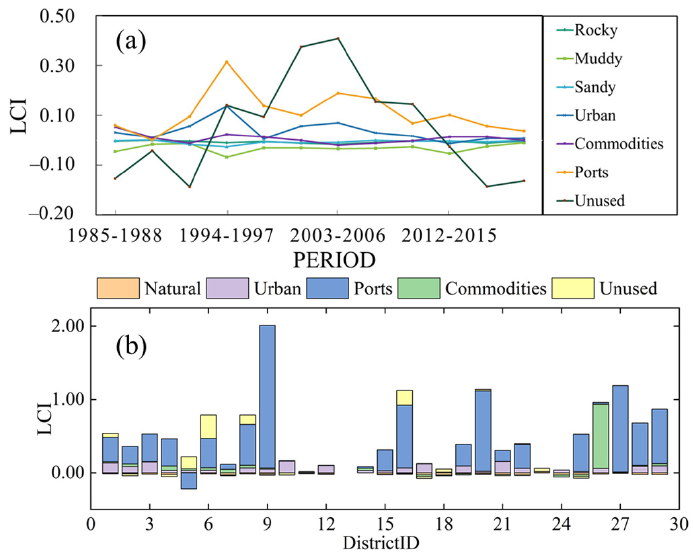
Figure 4. ( a ) LCI of all types of coastlines every three years from 1985 to 2020; ( b ) LCI of different coastlines in each district from 1985 to 2020.